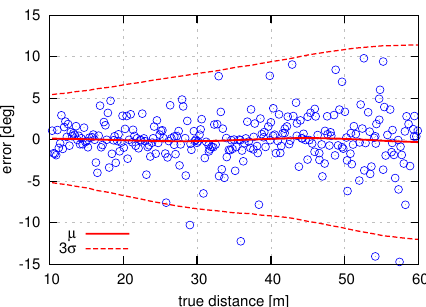
Figure 11: Error in φ measurement on synthetic